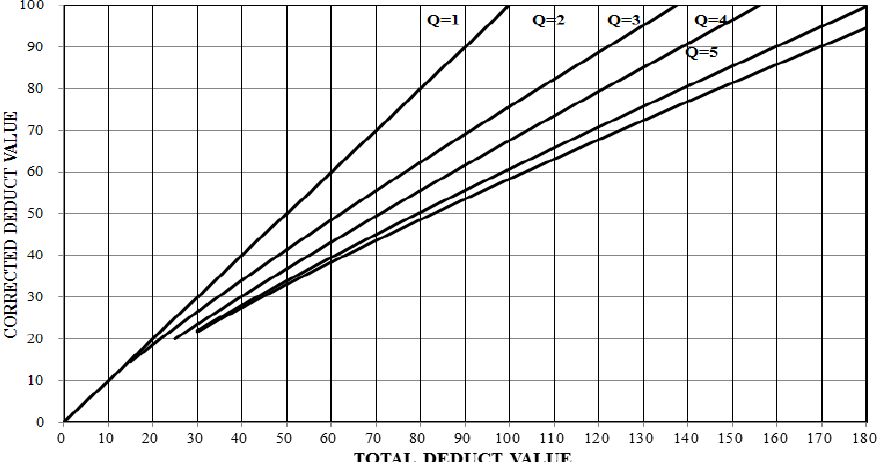
Figure 9. Developed corrected deduct value curves for asphalt pavement.